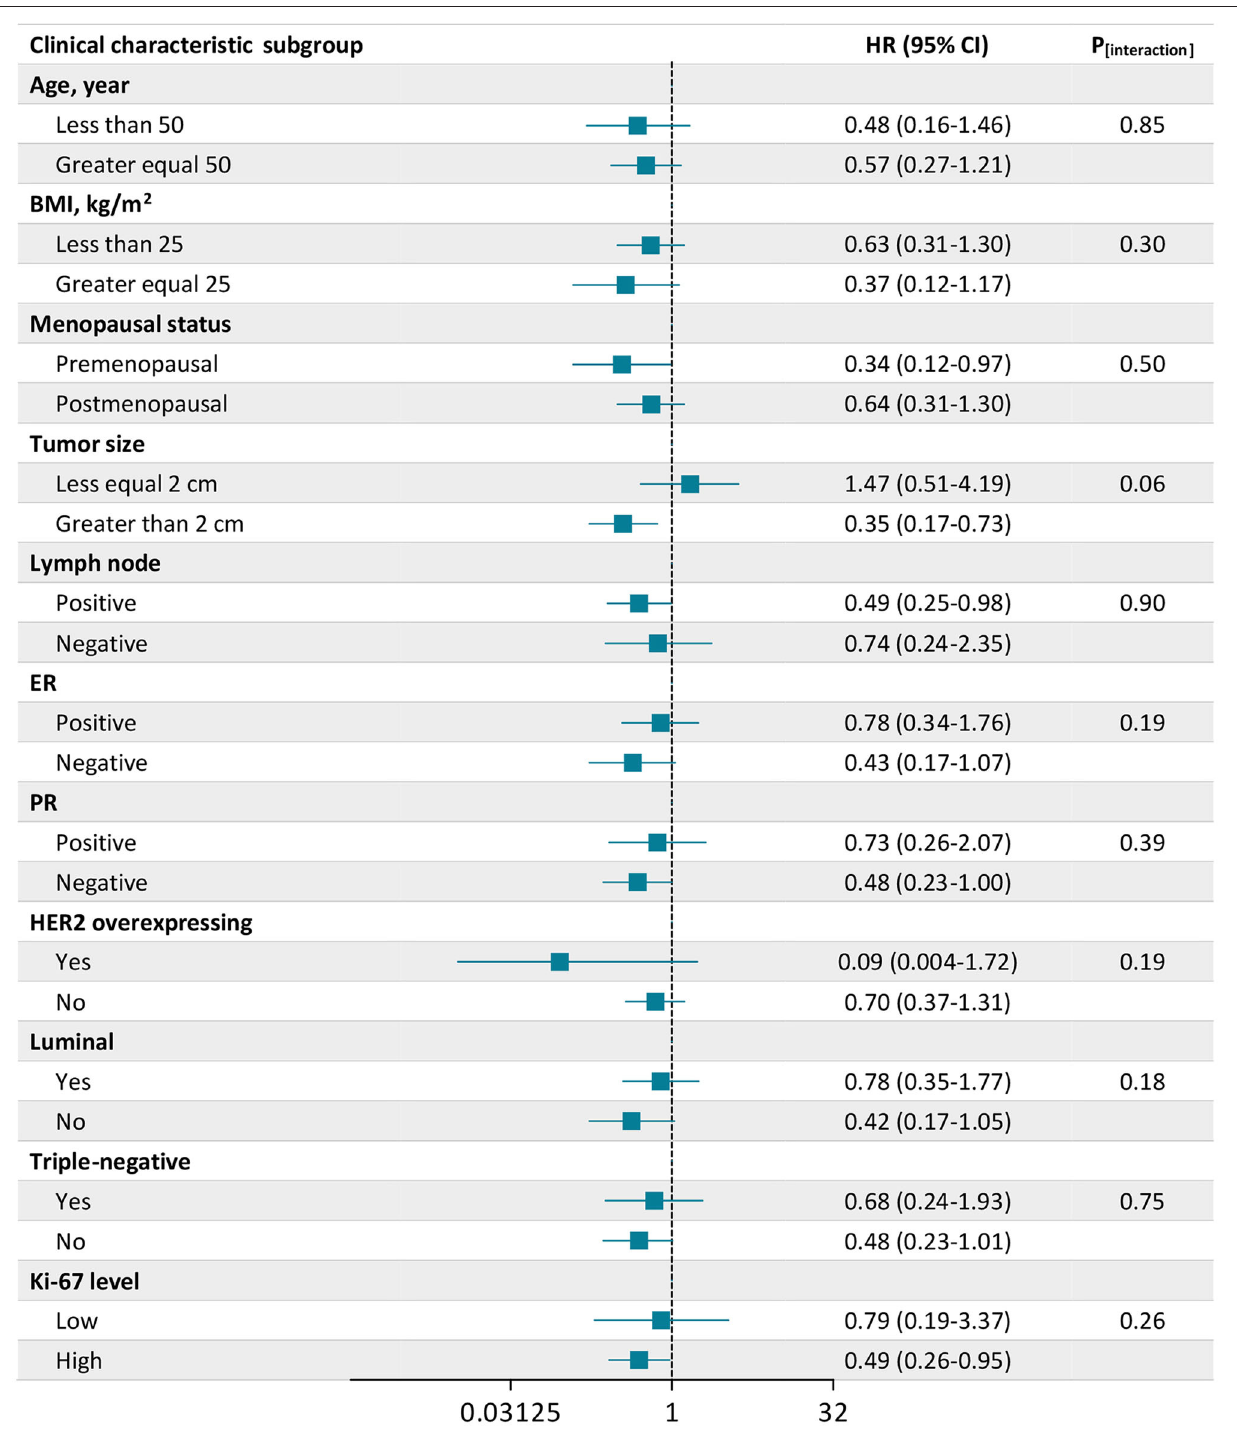
Frontiers in Oncology | www.frontiersin.org